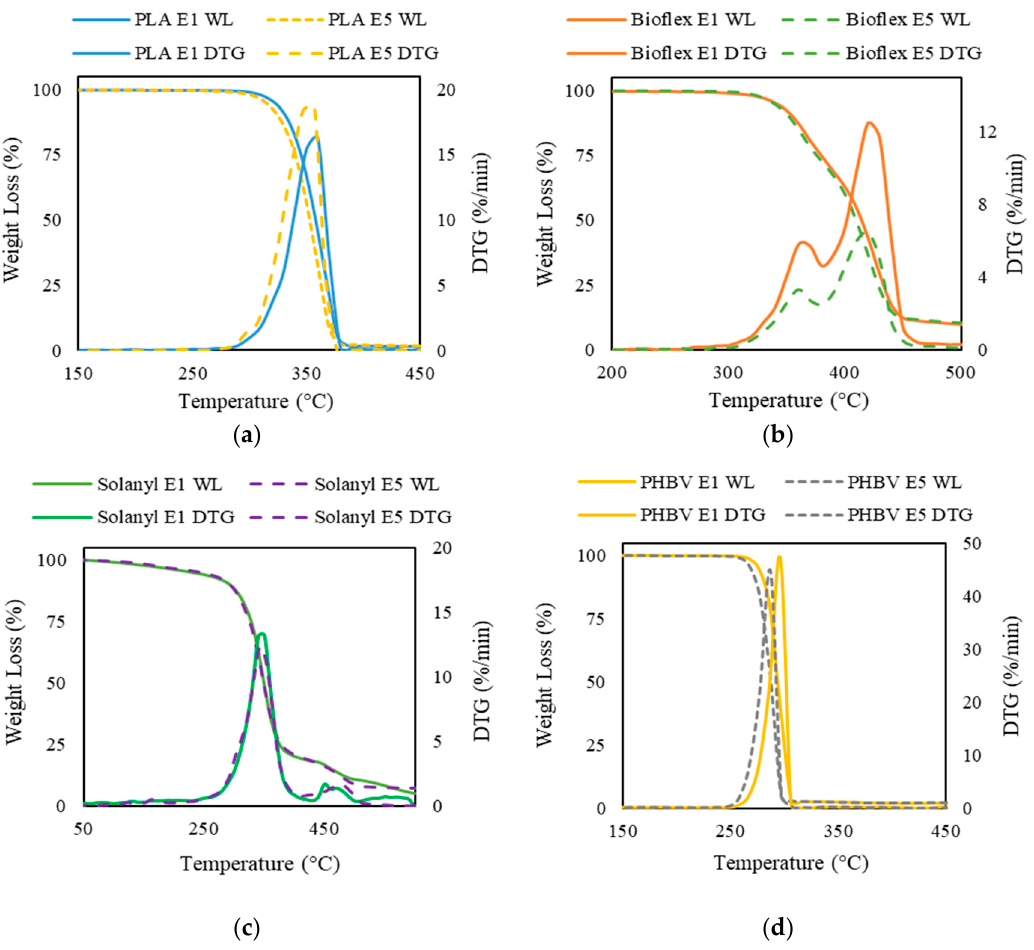
Figure 7. Thermogravimetric traces of virgin polymers (solid line) and recycled polymers (dashed line): ( a ) PLA; ( b ) Bioflex; ( c ) Solanyl; and ( d ) PHBV.